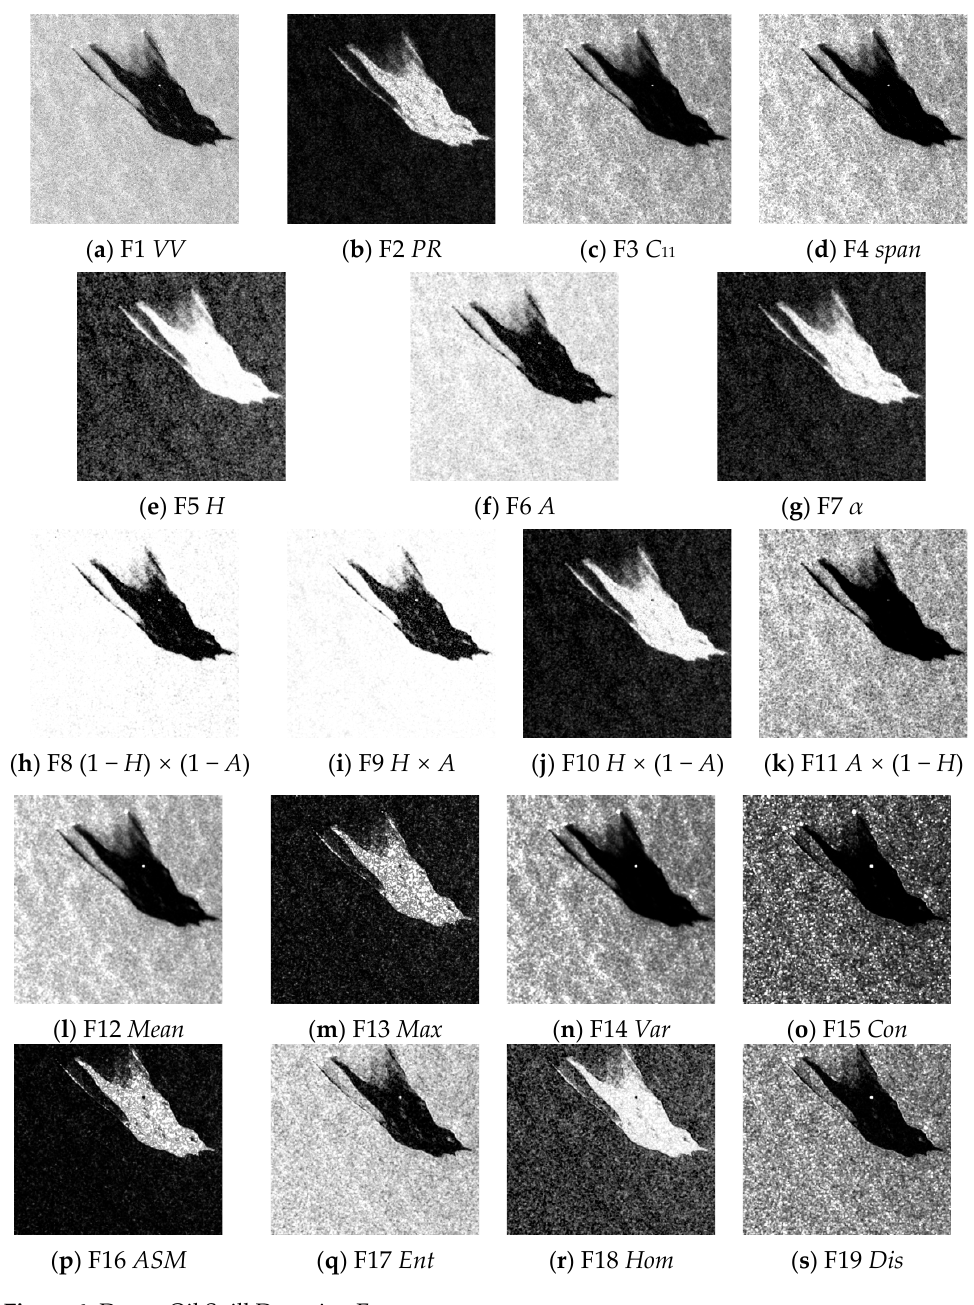
Figure 6. Data a Oil Spill Detection Features.